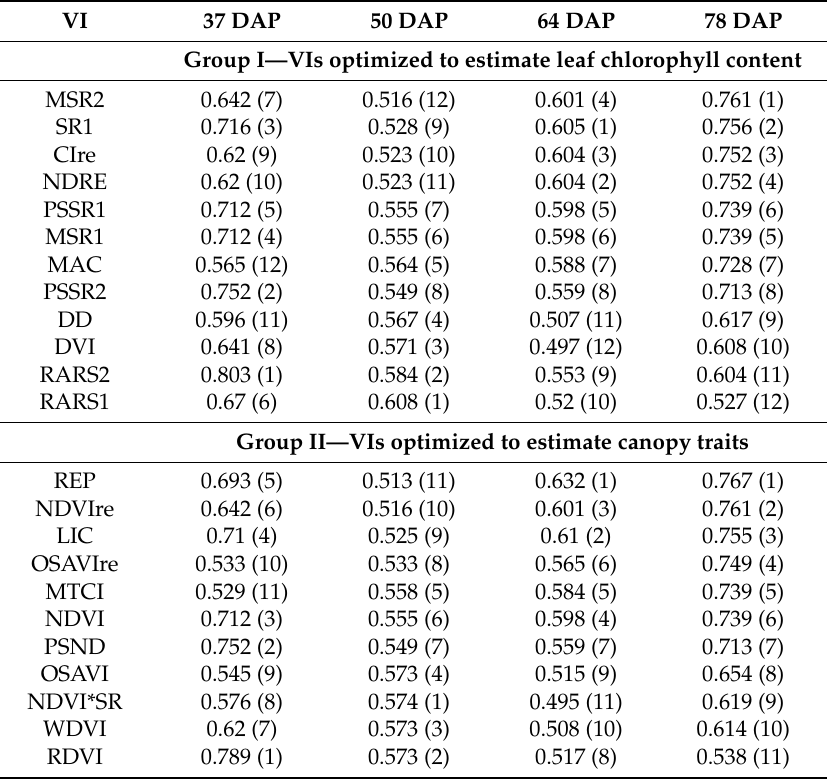
Table A6. C-statistic for pixel-wise binary classification according to T1 (“non-mixed” system) or T2 (“mixed” system) in each acquisition date using vegetation indices (VIs; Table A2) as independent variables. Only results concerning UAV-derived spectra and sampling units selected for validation of the logistic regressions are reported. Results are ordered (parentheses) according to values of C-statistic for the last acquisition (78 DAP).